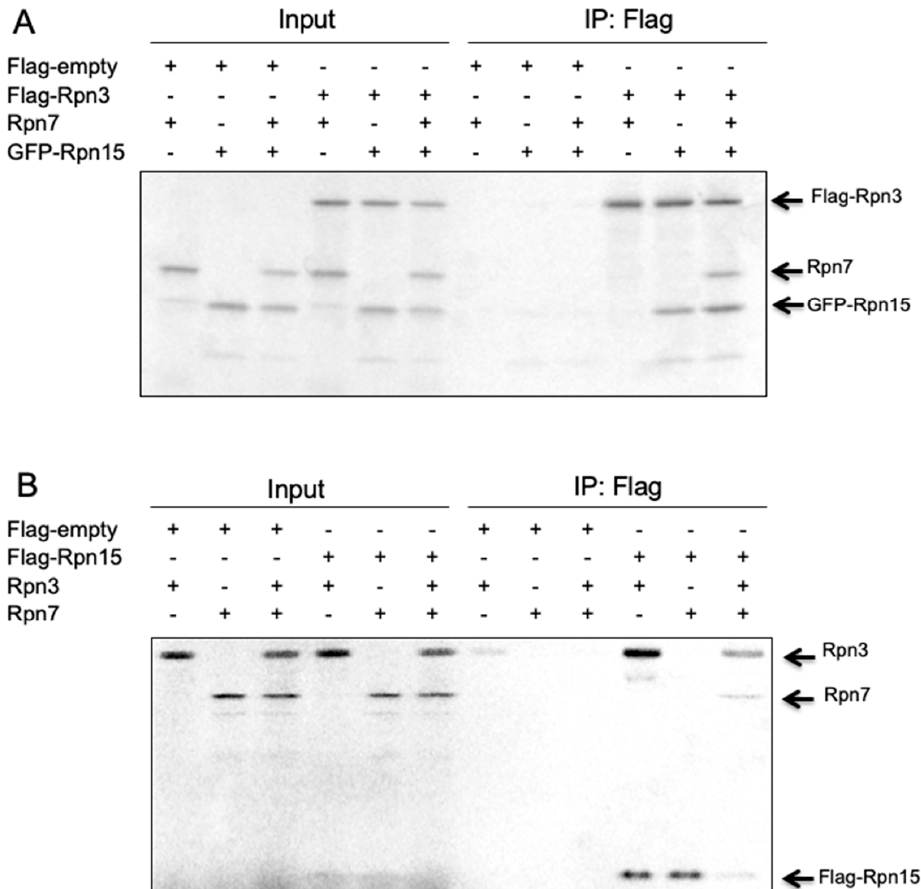
Figure 8. Rpn15 directly binds to Rpn3 and promotes Rpn3–Rpn7 association in vitro. Flag-Rpn3, Rpn7, and GFP-Rpn15 ( A ) or Flag-Rpn15, Rpn3, and Rpn7 ( B ) were cotranscribed / cotranslated and 35 S-radiolabeled in reticulocyte lysates in various combinations as indicated. Anti-Flag agarose beads were added to the reaction mixture, and the immunoprecipitates were run on an SDS-PAGE gel. Coimmunoprecipitated proteins with Flag-Rpn3 ( A ) or Flag-Rpn15 ( B ) were visualized using autoradiography.